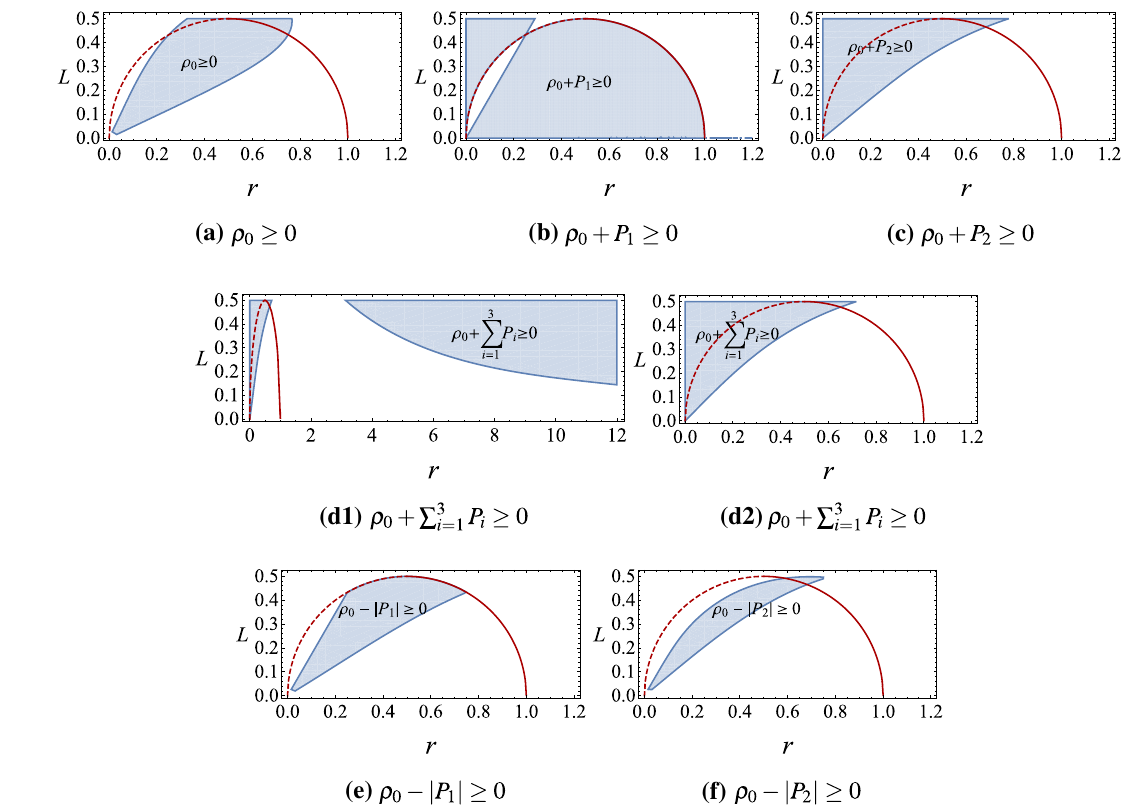
Fig. 7 The blue shadows show the physical regions in which the cor- responding inequalities are satisfied for the case of N = 1, where the dotted red curves are inner horizons while the solid ones outer horizons. Fig. 8 The blue shadows show the valid domains of various energy conditions for the case of N = 1. The dotted red curves are inner horizons while the solid ones outer horizons in this